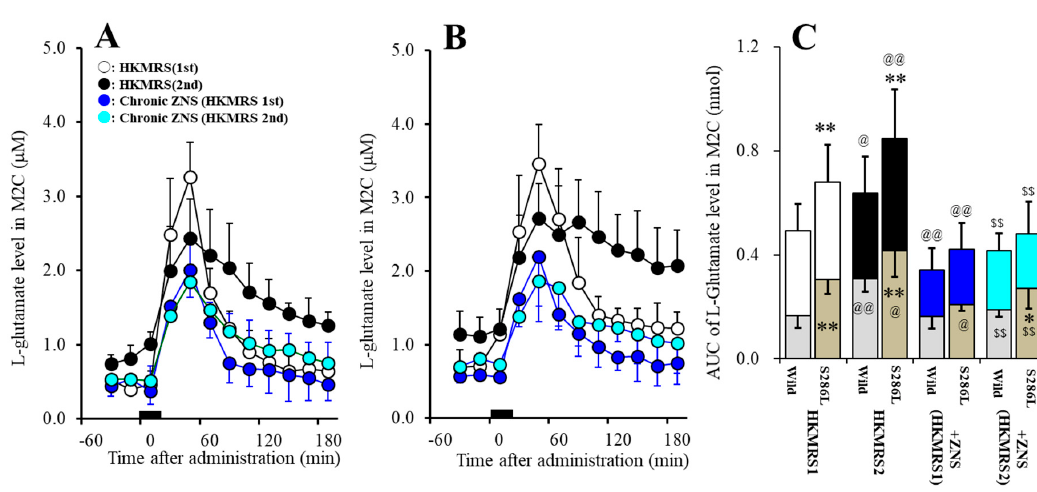
Figure 7. Effects of subchronic administration of therapeutic-relevant dose of ZNS (40 mg/kg/day for 7 days) on repetitive potassium-evoked L-glutamate release in the M2C of wild-type ( A ) and S286L-TG ( B ). Rats were subchronically administered with therapeutic-relevant dose of ZNS or ZNS free. Perfusion medium in the M2C was commenced with MRS. After the stabilization of L-glutamate level in the M2C, the perfusion medium was switched from MRS to HKMRS for 20 min (1 st potassium-evoked stimulation) (ZNS non-treated with 1 st stimulation: opened circles, ZNS administered with 1 st stimulation: red circles). After the 1 st potassium-evoked stimulation, the perfusate was returned to MRS for 240 min (recovery). Following recovery, the perfusate was switched to HKMRS for 20 min again (2 nd potassium-evoked stimulation). After the 2 nd potassium-evoked stimulation, perfusate was returned to MRS. Ordinates indicate mean extracellular L-glutamate level ( µ M) (N = 6), and abscissas indicate time after 1 st or 2 nd potassium-evoked stimulations (min). Black bars indicate the perfusion with HKMRS (1 st and 2 nd potassium-evoked stimulation). ( C ) indicates the AUC value of extracellular L-glutamate level (nmol) before (basal extracellular L-glutamate level) and after potassium-evoked stimulation (from 20 to 180 min) of Figure 7A,B. Gray columns in Figure 7C indicate the AUC values of basal extracellular levels of L-glutamate in Figure 7A,B. * P < 0.05, ** P < 0.01; relative to wild-type, @ P <